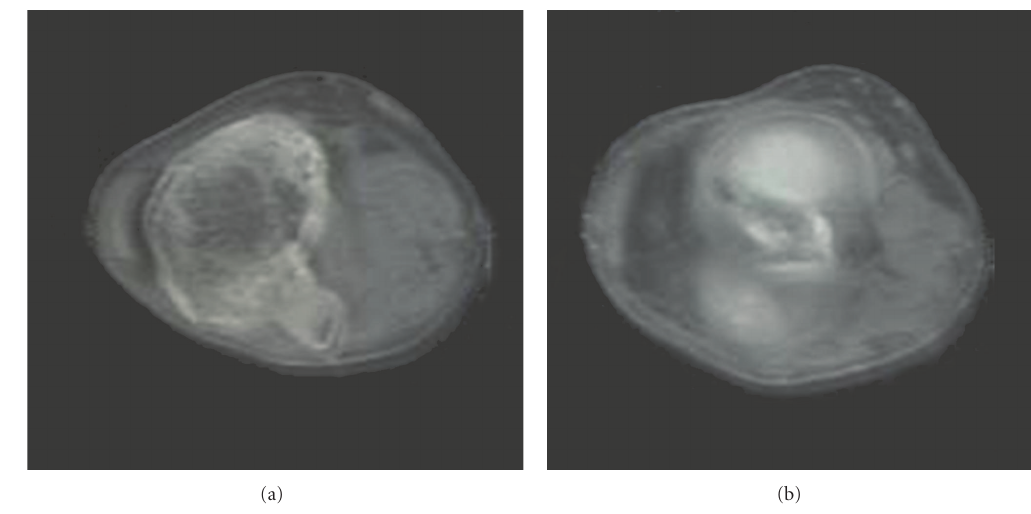
Figure 1: A large mass of anterior left knee involving bone and soft